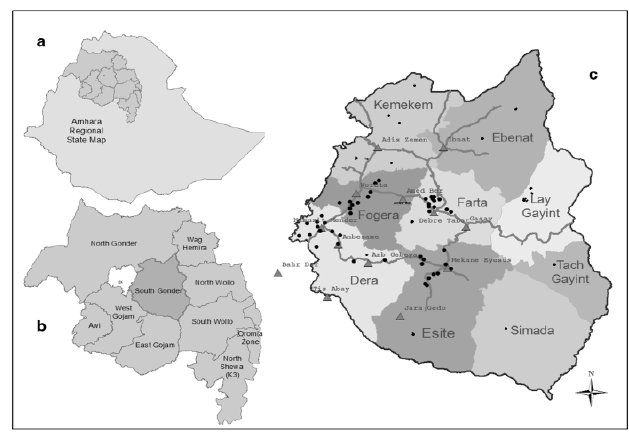
Fig. 1. (a) Map of Ethiopia. (b) Regional map of Amhara. (c) Map of the study sites in Amhara province, Ethiopia